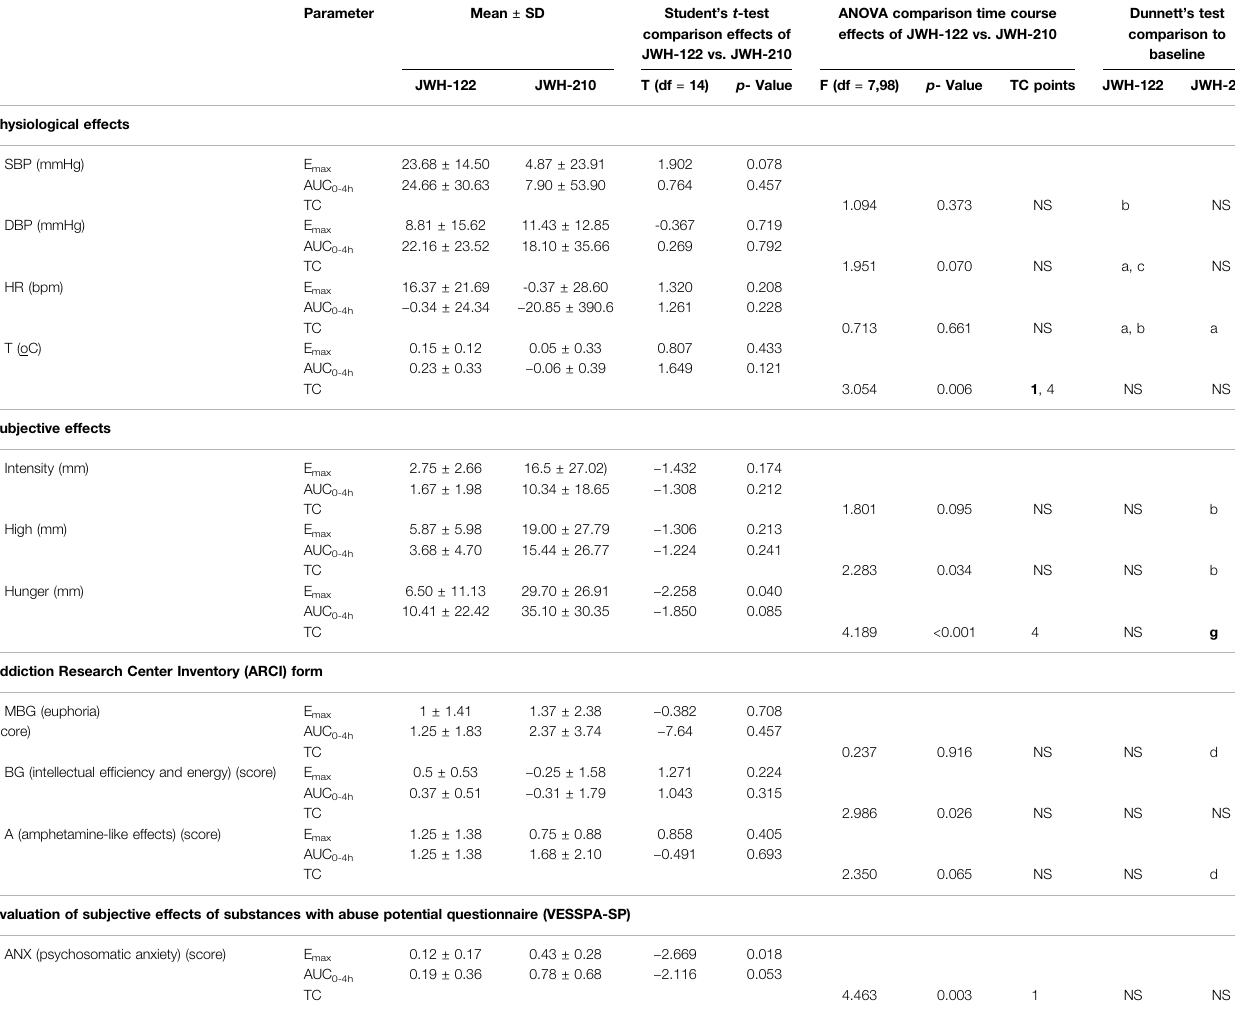
TABLE 2 | Summary of signi fi cant statistical results on the physiological and subjective effects observed after administration of JWH-122 ( n (cid:1) 8) and JWH-210 ( n (cid:1)